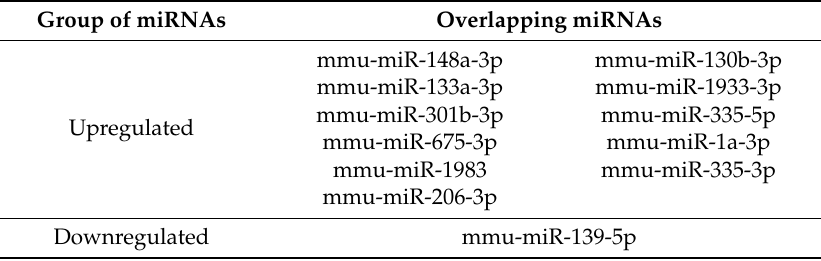
Figure 3. Identification of miRNAs involved in mRNA regulation. ( A ) Thirty-five upregulated miRNAs were identified, 11 of which led to the downregulation of target DEGs. ( B ) Fourteen downregulated miRNAs were identified, only one of which led to the upregulation of target DEGs. Table 1. Overlapping miRNAs regulating target DEGs. Table 1. Overlapping miRNAs regulating target DEGs.